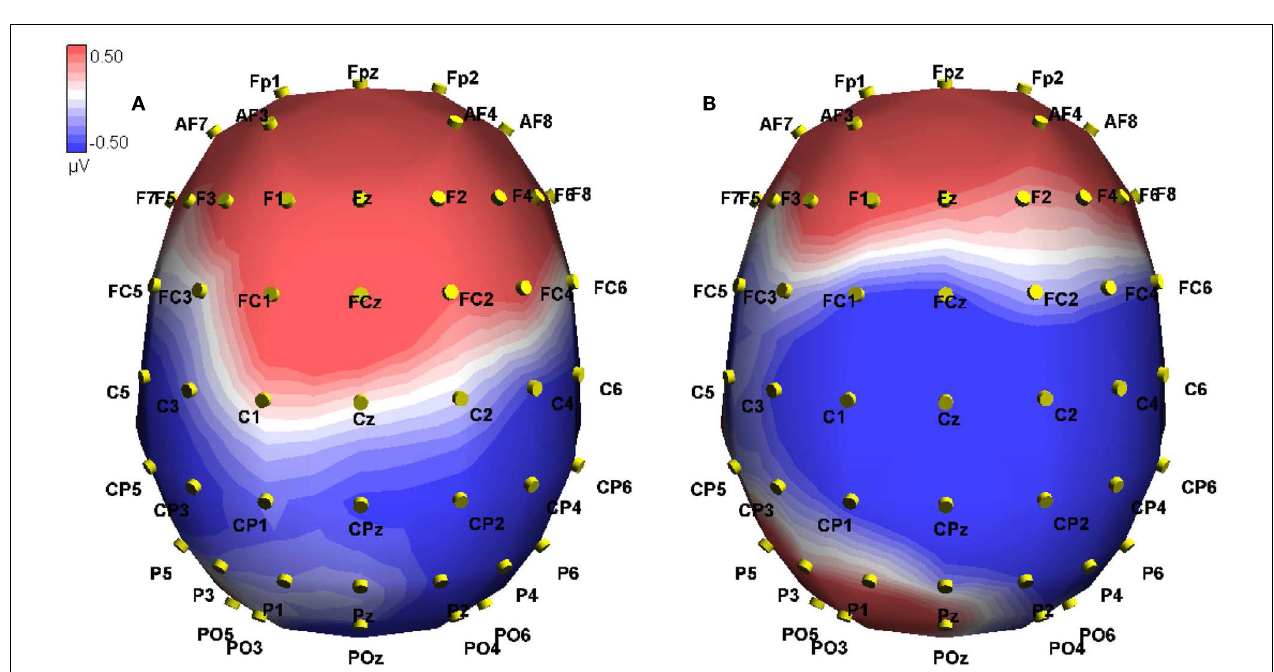
FIGURE 5 | Event-related potential in microvolts across the scalp at 364ms post onset of the critical word, approximately at the peak of the difference. Blue hues indicate negative potentials, red hues positive potentials.The two conditions shown areTrue-Mismatch (A) andTrue-Match (B) .